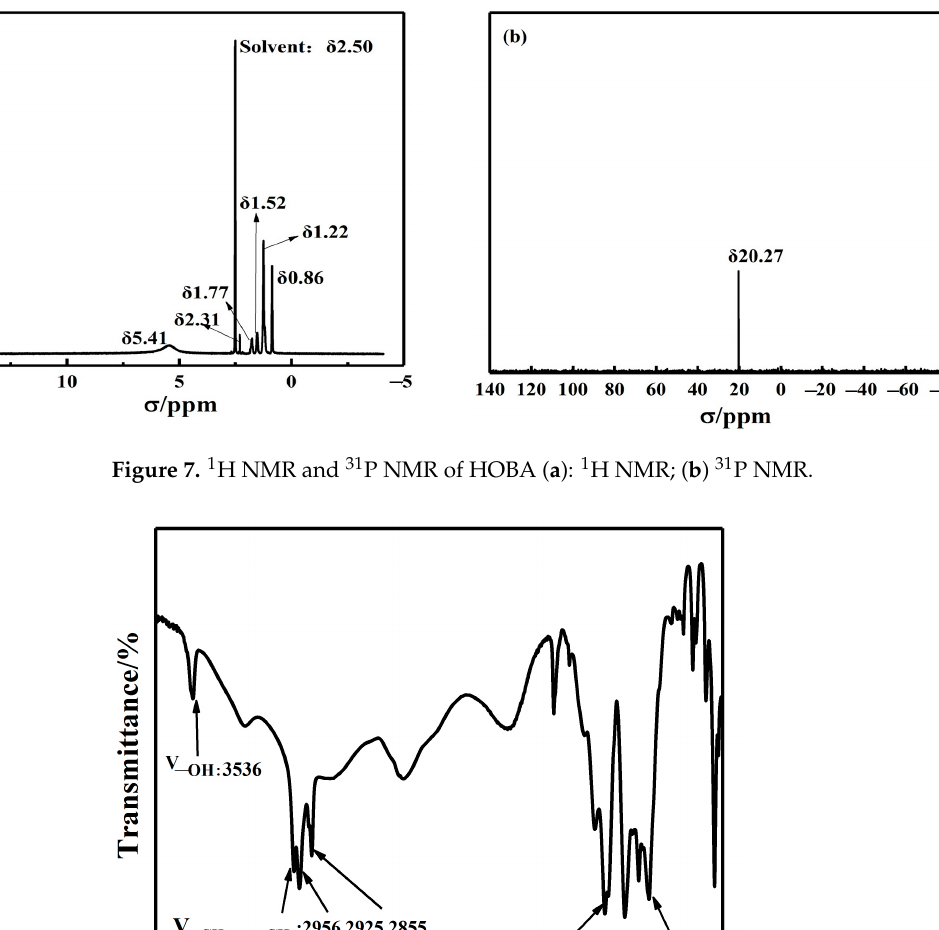
Figure 8. The FTIR spectrum of HOBA.